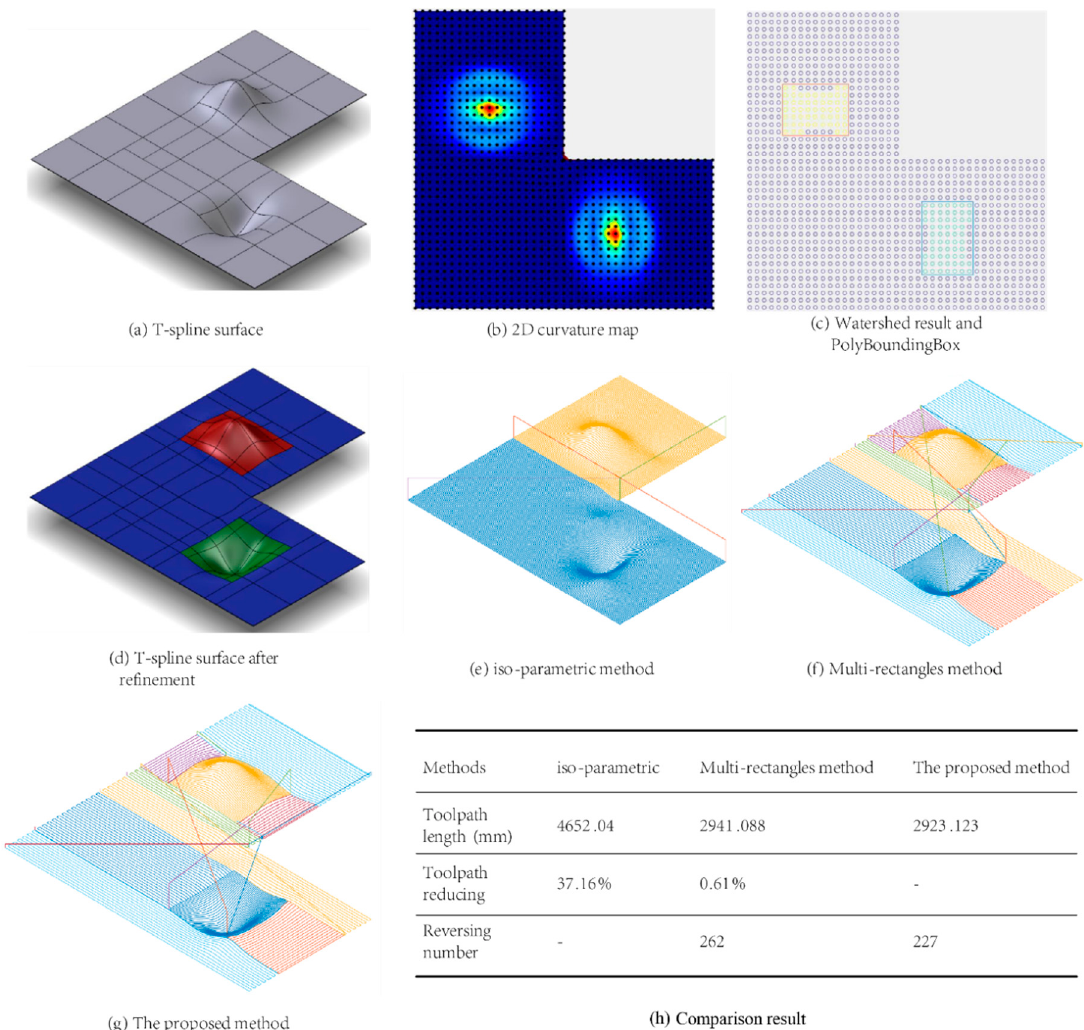
Figure 8. Demonstration and comparison of watershed-based toolpath generation of T-spline surface 2.